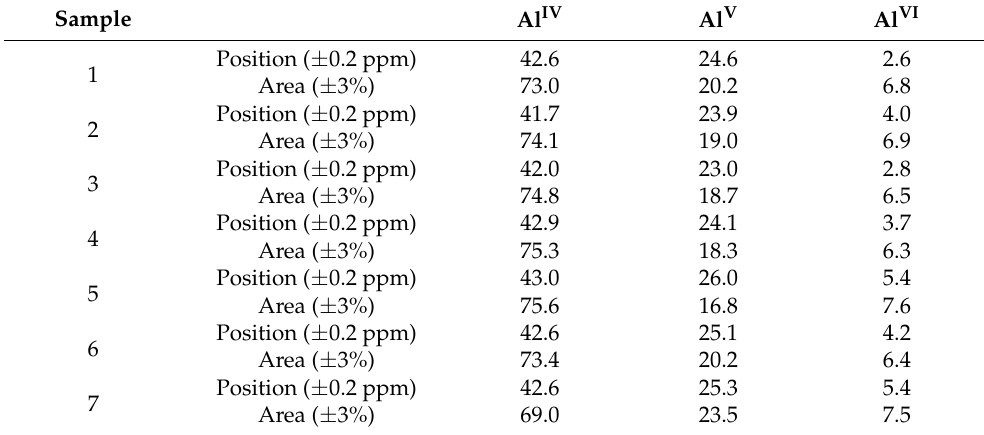
Table 2. Calculation results of GIM model fitting of 27 Al NMR